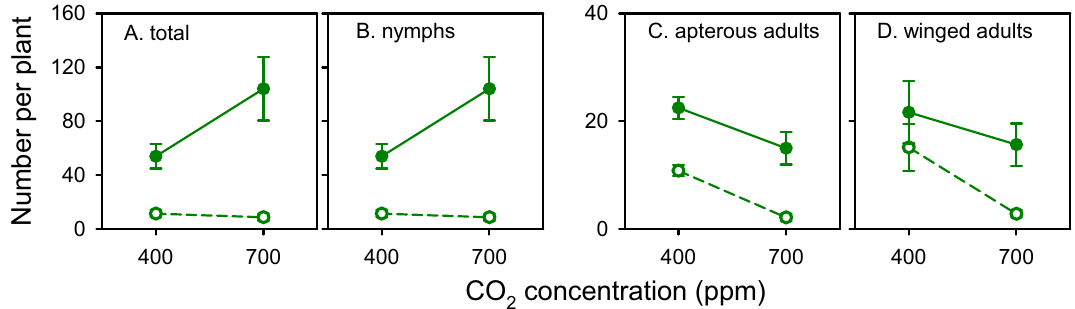
Figure 7. Effect of nitrogen (high: closed symbol, low: open symbol), [CO 2 ] and their interaction on the number Rophalosiphon padi in whole-plant assay 3. ( A ) Total number of aphids, ( B ) nymphs, ( C ) apterous adults, and ( D ) winged adults. Error bars are two standard errors of the mean.